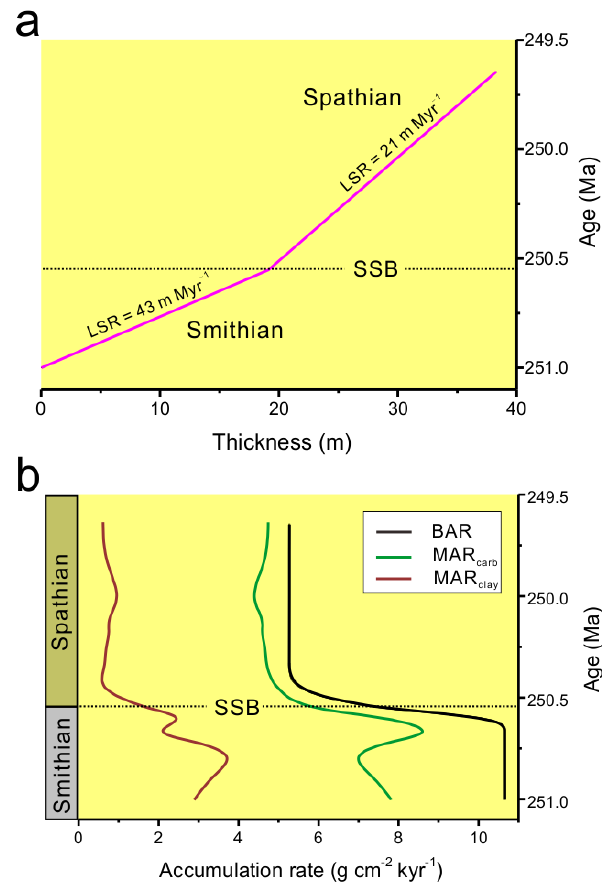
Figure 3. (a) Age–depth model and (b) sediment accumulation rates around the SSB in the Shitouzhai section. BAR, MAR carb , and MAR clay stand for bulk accumulation rate, carbonate mass ac- cumulation rate, and clay mass accumulation rate, respectively. SSB stands for Smithian–Spathian